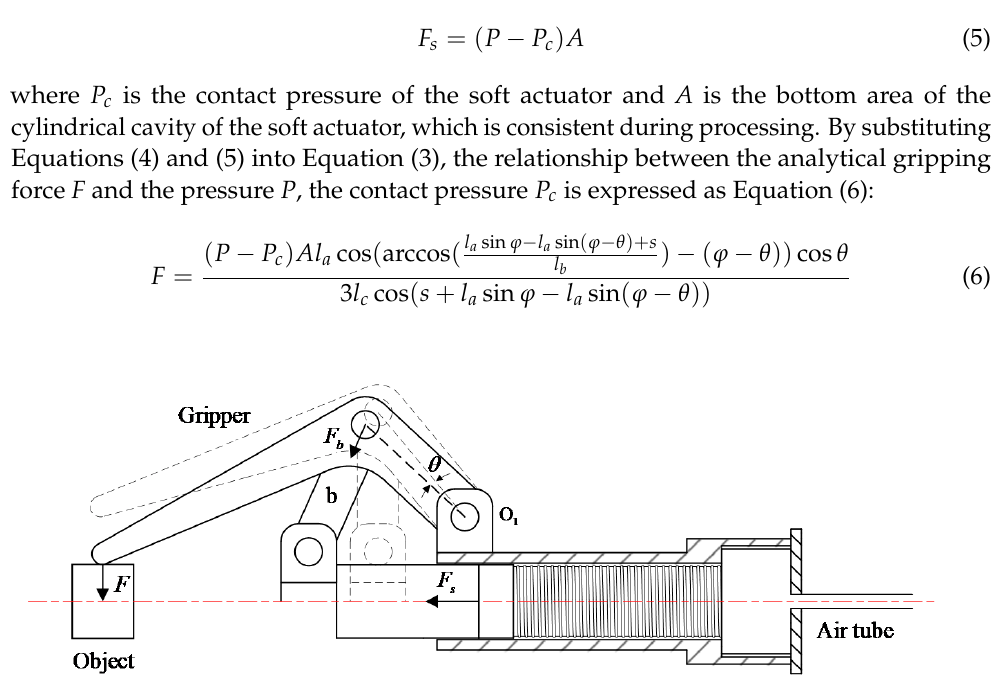
where s is the extension length of the soft actuator. The relation between the pressure P and the axial thrust force F s of the soft actuator is expressed by Equation (5).